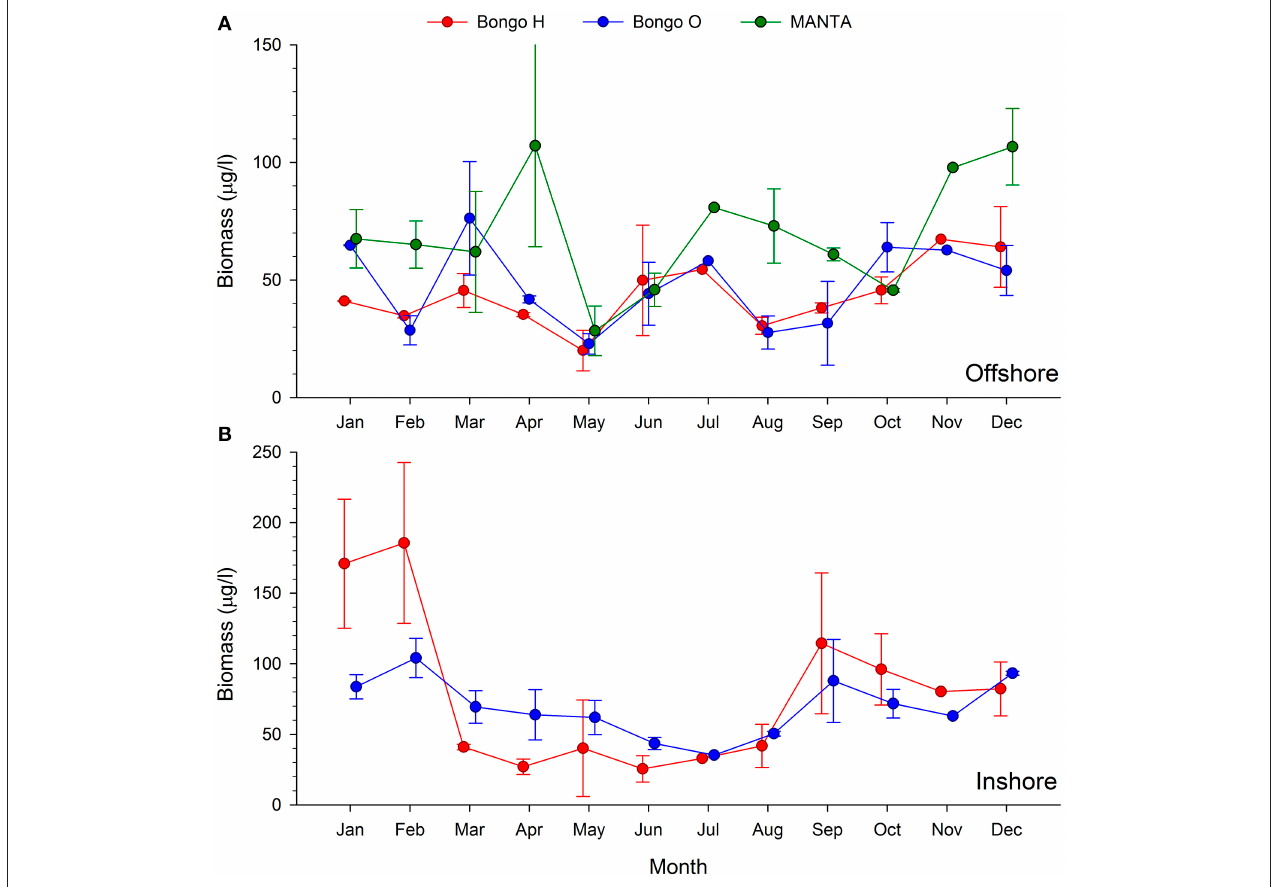
FIGURE 4 | Monthly trends of bulk zooplankton biomass ( µ g/l) collected using the MANTA and bongo nets offshore (A) and bongo nets inshore (B) .